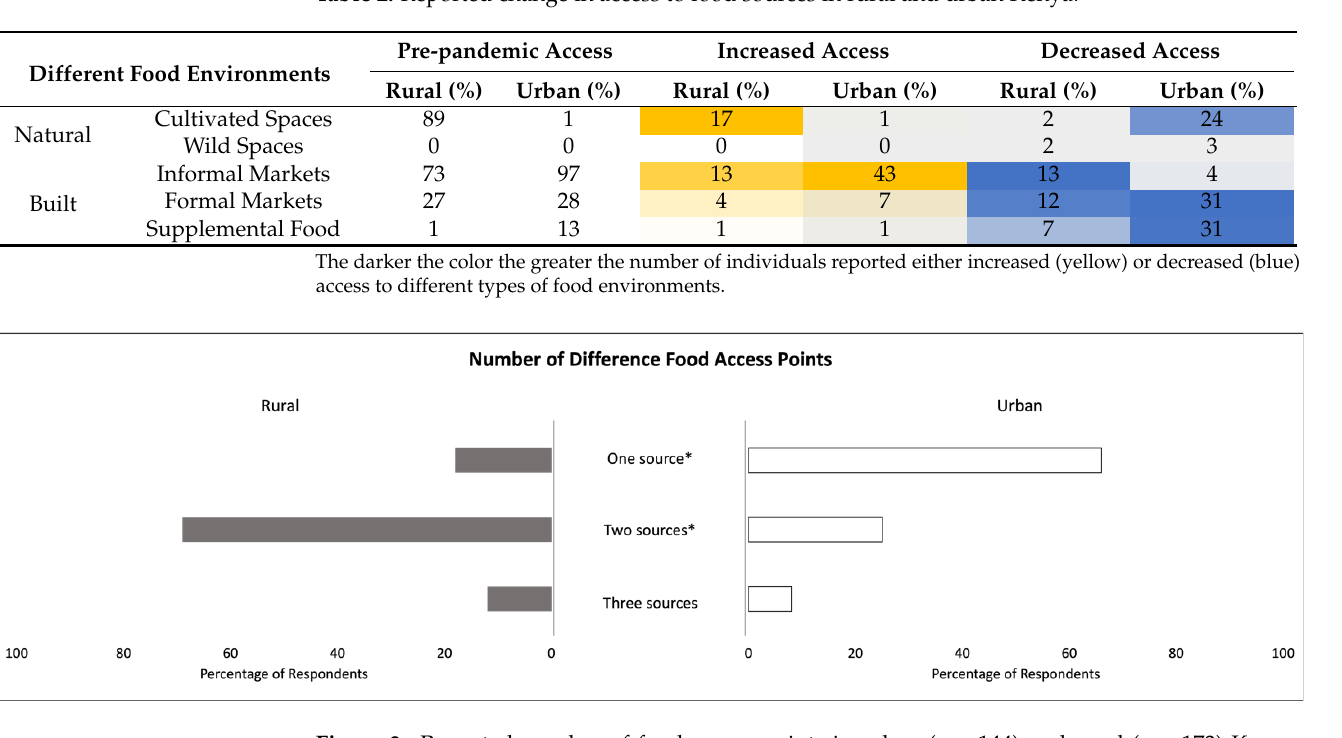
Figure 3. Reported number of food access points in urban ( n = 144) and rural ( n = 173) Kenya. * Statistically significant at p < 0.05 ( χ 2 test).